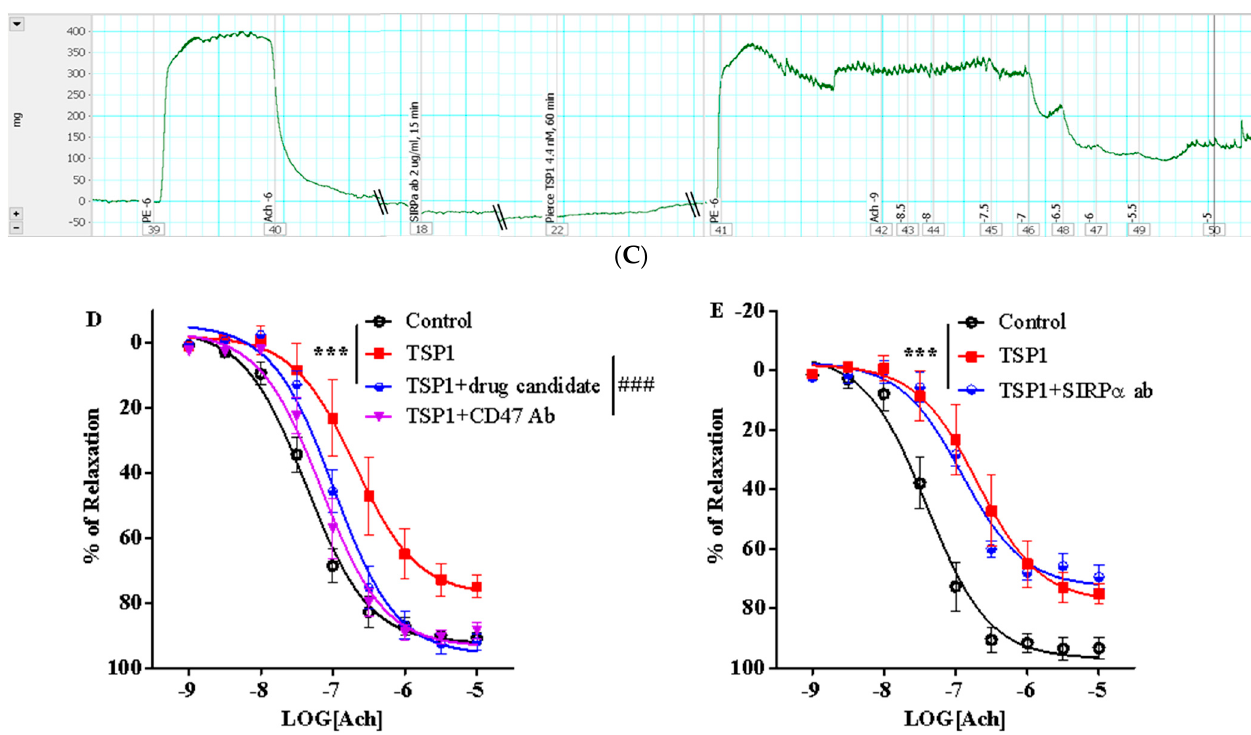
Figure 4. Thrombospondin 1 (TSP1) − impaired endothelium-dependent vasorelaxation was prevented by treatment with the proposed drug candidate, but not by blocking signal-regulatory protein α (SIRP α ). Representative force vs. time traces recording from endothelium intactness test to acetylcholine-induced vasorelaxation by isolated murine thoracic aorta pre-treated with the proposed drug candidate 6.6 nM ( A ), CD47 antibody (CD47 ab) 1 µg/mL ( B ), or SIRP α antibody (SIRP α ab) 2 µg/mL ( C ) in the presence of Pierce TM —TSP1 4.4 nM (PE: phenylephrine; Ach: acetylcholine; the numbers marked in the recording are the logarithmic values of stimulant concentrations). Prior to receiving any treatment, the vessel segments were pre-contracted with 1 × 10 − 6 M PE followed by 1 × 10 − 6 M Ach-stimulated endothelium-dependent vasorelaxation to confirm endothelial intactness. ( D ) Concentration response curves of isolated mouse thoracic aorta exposed to TSP1, in the presence of vehicle, CD47-based drug candidate, or CD47 antibody. ( E ) Concentration response curves of isolated mouse thoracic aorta exposed to TSP1, in presence of vehicle or SIRP α antibody (***, p < 0.0001, TSP1, TSP1 + drug candidate, or TSP1 + SIRP α ab vs. control; ###, p < 0.0001, TSP1 + drug candidate or TSP1 + CD47 antibody vs. TSP1).